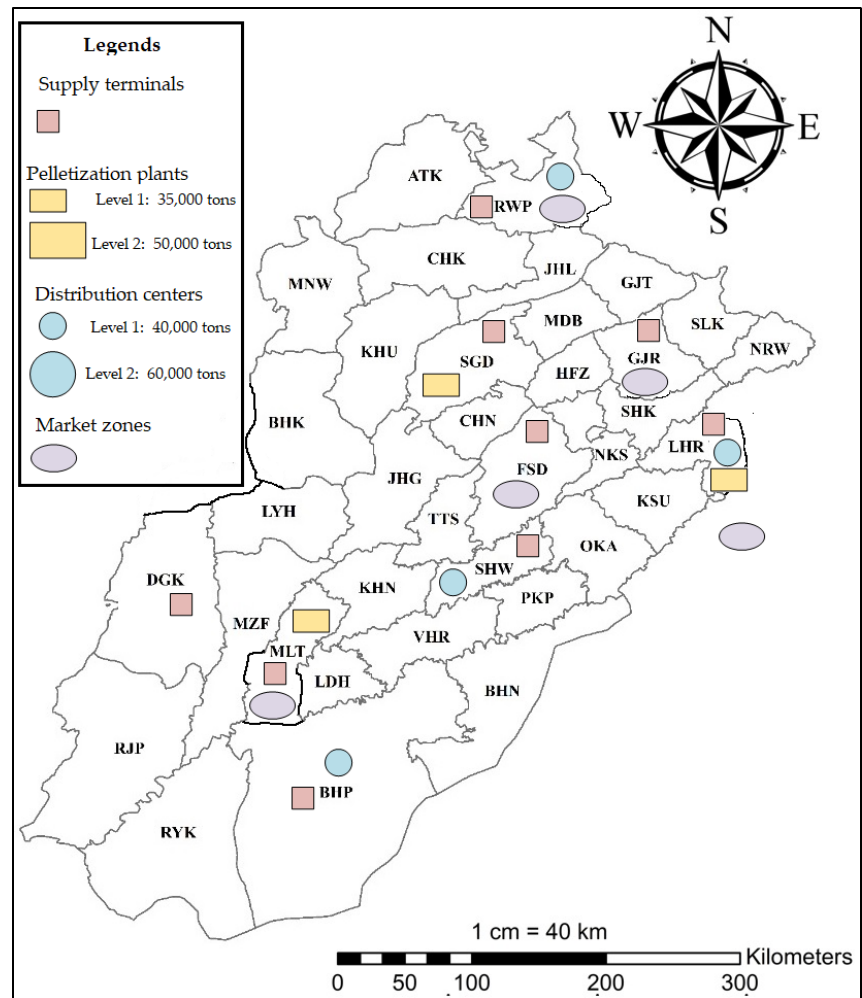
Figure 3. Potential wood pellet production SC sites for the given case.